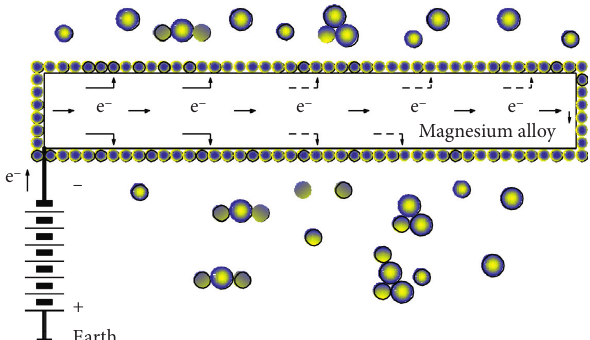
Figure 6: Schematic diagram of a cathodic protection method of an external power